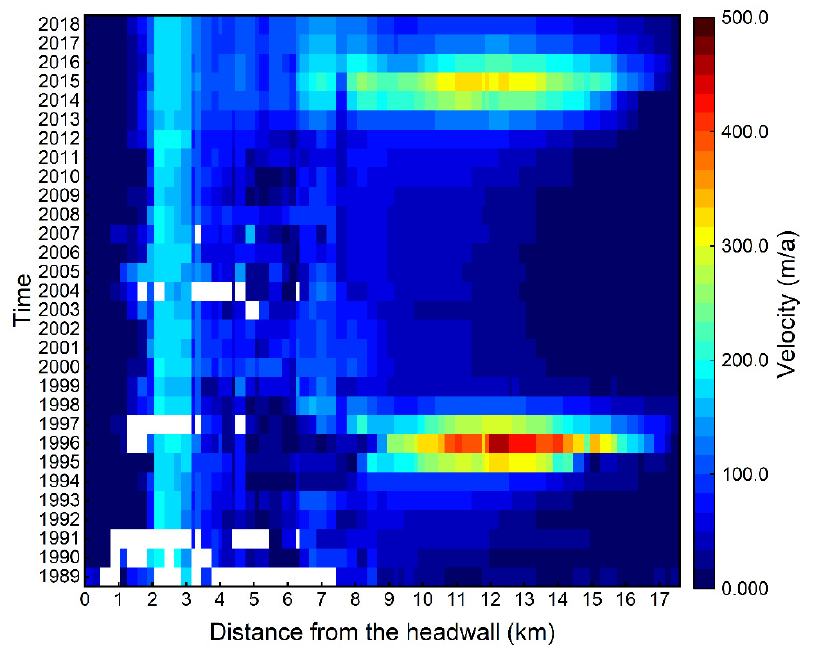
Figure 6. Spatial and temporal distributions in glacier velocity along the longitudinal profile in Figure 1 during 1989–2018 (Data source: ITS_LIVE).